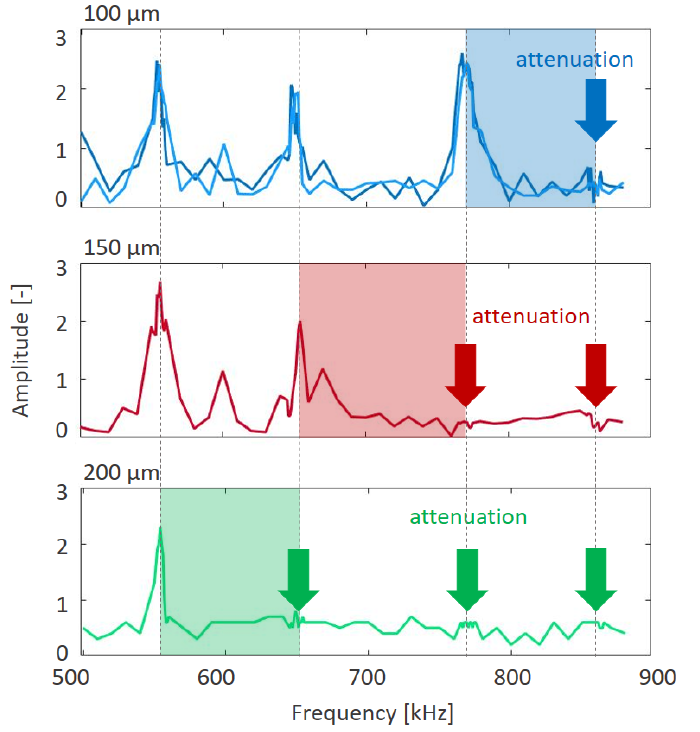
Figure 5. Signal transmitted by the micro-phononic structures at varying frequency for the 100 µm, 150 µm and 200 µm unit cell